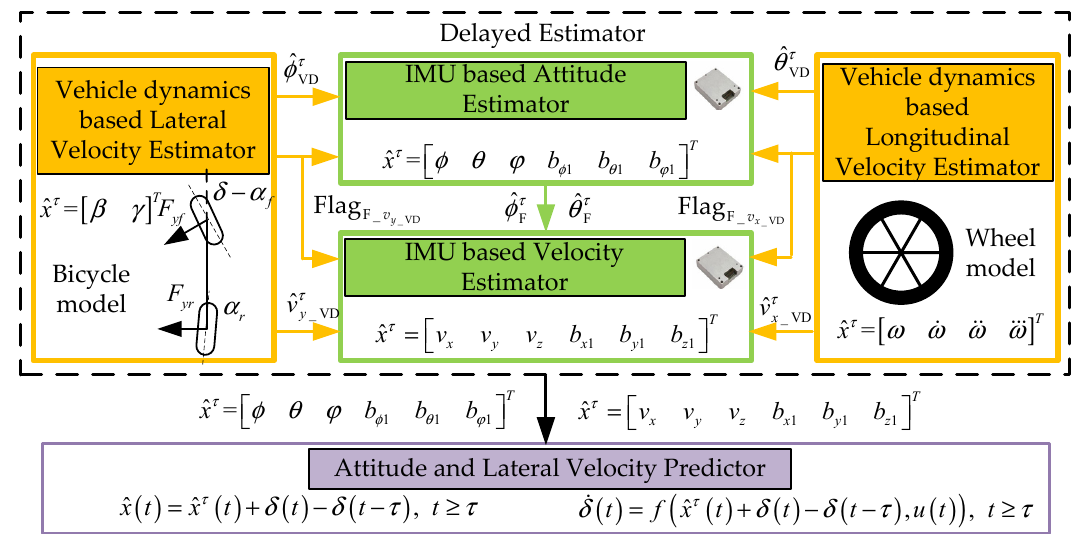
Figure 1. Overview of proposed slip angle and attitude estimation architecture. IMU, inertial measurement unit.